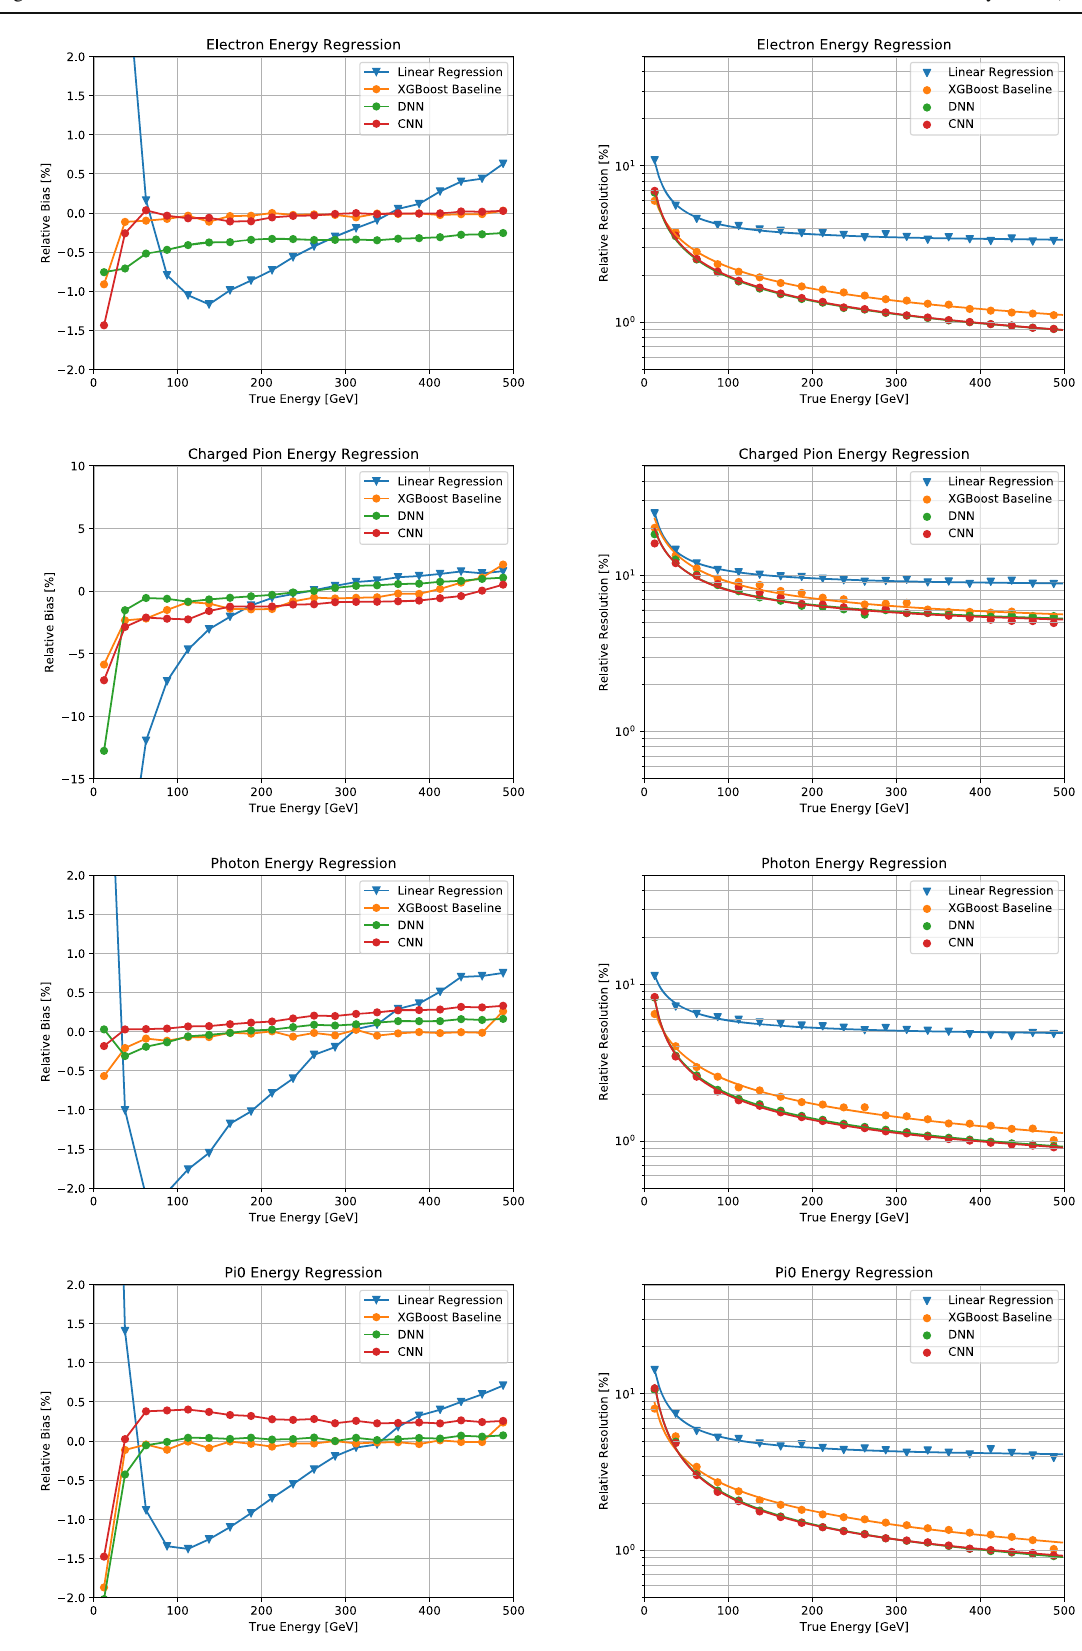
Fig. 34 Regression bias (top) and resolution (bottom) as a function of true energy for energy predictions on the REC dataset with fixed incident angle (90 ◦ ). From top to bottom: electrons, charged pions, photons, and neutral